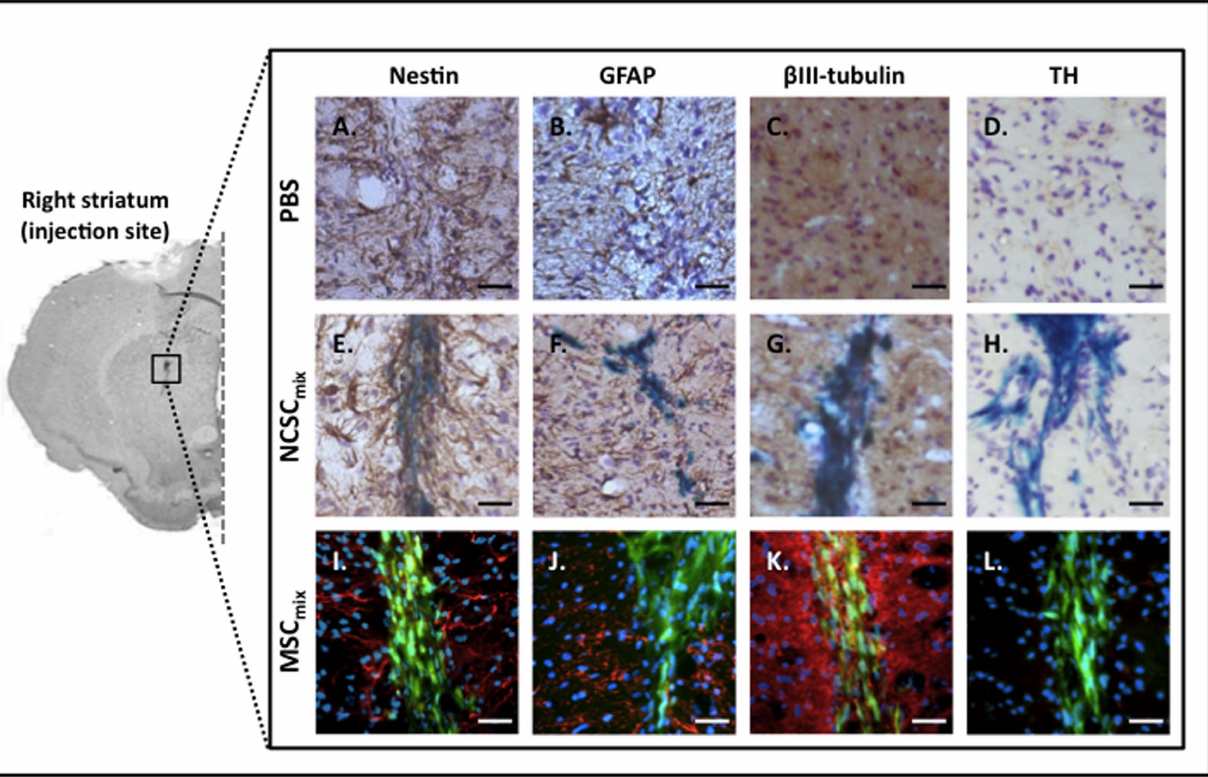
Figure 4. In vivo characterization of brain-injected NCSC mix and MSC mix . All cells were implanted in the correct brain site, in each mouse that was included in the study. Transplanted NCSC mix were detected by X-gal staining ( blue ) and MSC mix were identified thanks to CTG staining (green). Grafted cells conserved their in vitro phenotype, whatever the delay post-transplantation : NCSC mix were nestin-positive ( brown , A) whereas MSC mix were not ( red , I). No cells did differentiate into GFAP-positive cells (NCSC mix , brown , F; MSC mix , red , J). Only few positive cells in NCSC mix were b III-tubulin-positive ( brown , G), and no specific positivity was noticed for MSC mix ( red , K). Finally, grafted cells were negative for TH (NCSC mix , brown , F; MSC mix , red , J). Nestin and GFAP staining ( brown or red ) are detected around the transplanted cells and are linked with injection-induced inflammation (n $ 3 for each group, at each delay post-transplantation). Scale bars=25 m